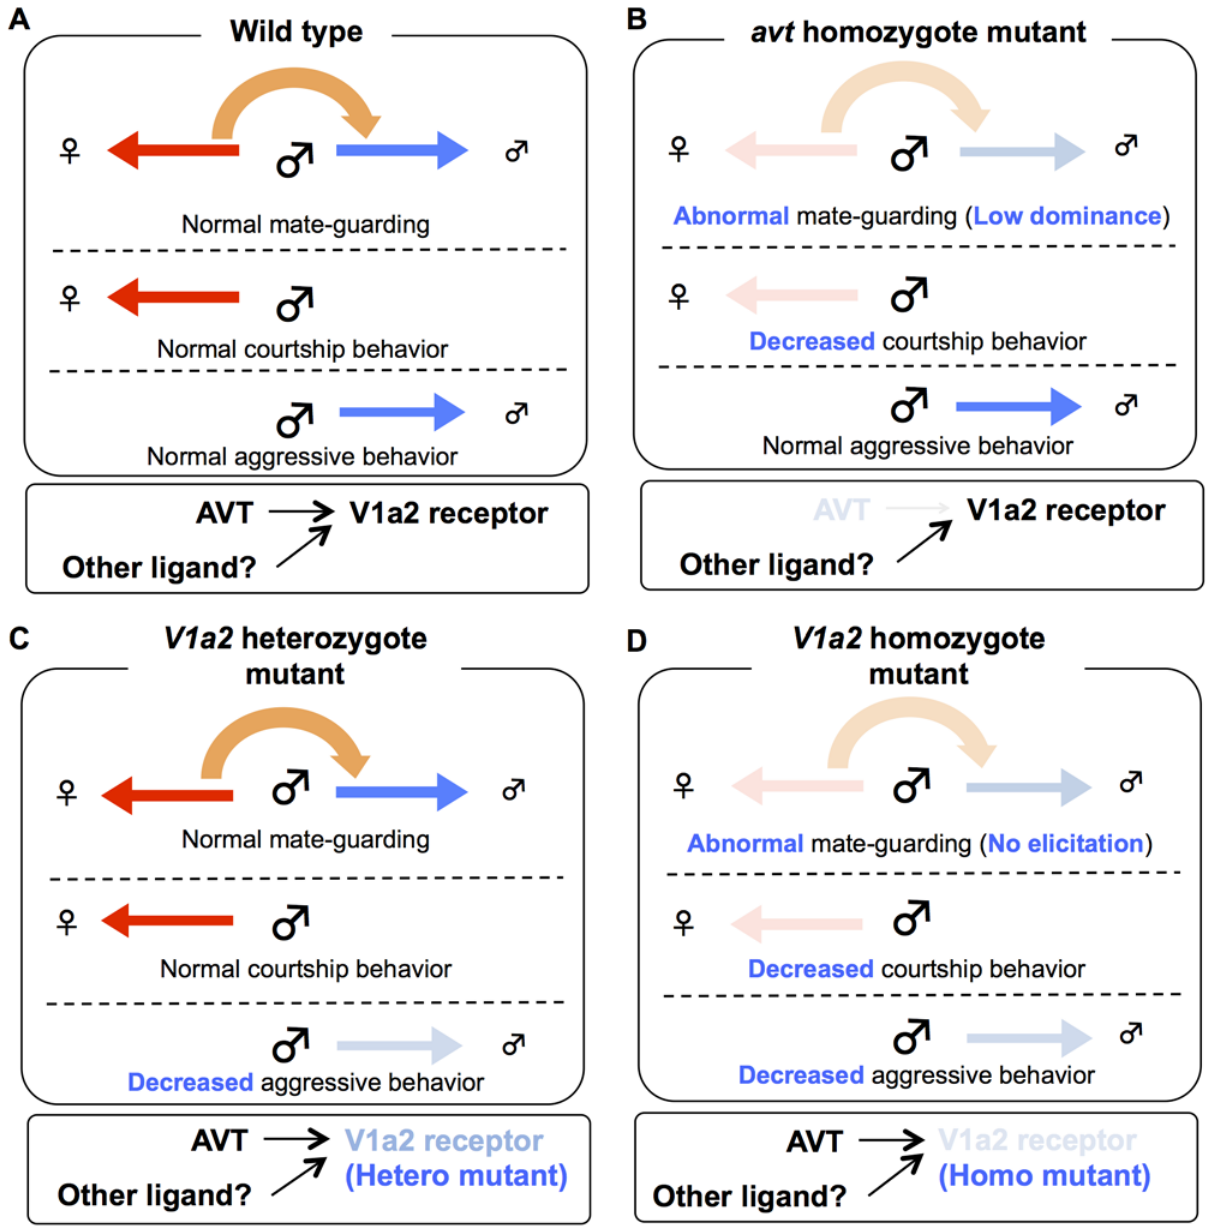
Fig 5. Possible model of AVT system in mate-guarding, aggressive and courtship behaviors. (A) Mate-guarding requires two different types of motivation: sexual motivation toward the opposite sex and competitive motivation toward the same sex, while courtship and aggressive behaviors require social motivation to either the opposite (red arrow) or same (blue arrow) sexes. When mate-guarding emerges in a triadic relationship, the presence of a potential mating partner may engage competitive motivation toward rival males via AVT system, leading to male-male competition (orange arrow). (B) The homozygote avt mutant males exhibited fewer courtship displays than wild-type males (Fig. 4B), whereas the mutant males exhibited normal aggression (Fig. 4A). Thus avt mutants normally have sexual motivation, but not competitive motivation toward the same sex. Decreased sexual motivation toward the opposite sex may cause low dominance of male-male competition in mate-guarding. avt was required just for dominance of mate-guarding. avt was not required for either normal aggressive behaviors or elicitation of mate-guarding, suggesting the presence of redundant system activating V1a2 receptor. (C) The heterozygote V1a2 mutant males exhibited normal courtship displays (Fig. 4B), whereas they exhibited low aggression (Fig. 4A). Thus heterozygote V1a2 mutants normally have competitive motivation, but not sexual motivation toward the opposite sex. Decreased competitive motivation towards the same sex has no effect on male-male competition in mate-guarding, because sexual motivation may dominantly drive the motivation for mate-guarding. The single functional V1a2 allele may not produce enough of a gene product, leading to attenuated aggression. (D) The homozygote V1a2 mutant males exhibited decreased courtship displays and low aggression (Figs. 4A and 4B). Thus homozygote V1a2 mutants did not normally have social motivation to either the same sex or opposite sex. V1a2 was required for elicitation of mate-guarding (Fig.